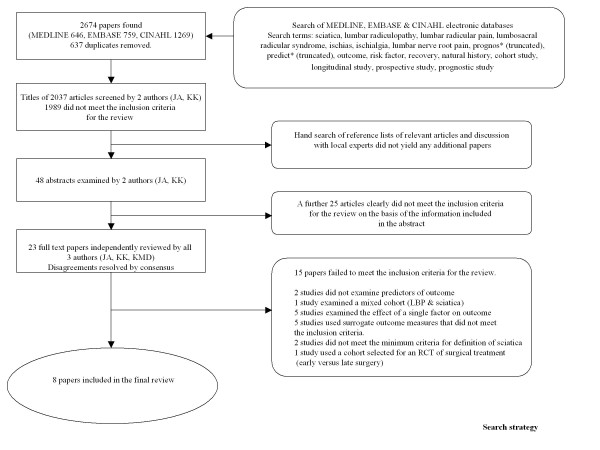
Search Strategy.